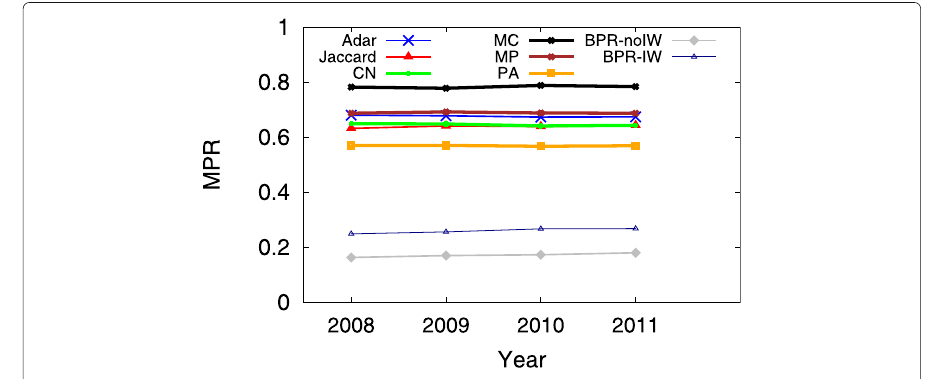
Fig. 8 MPR on 07/01 during 2008-2011, when K =